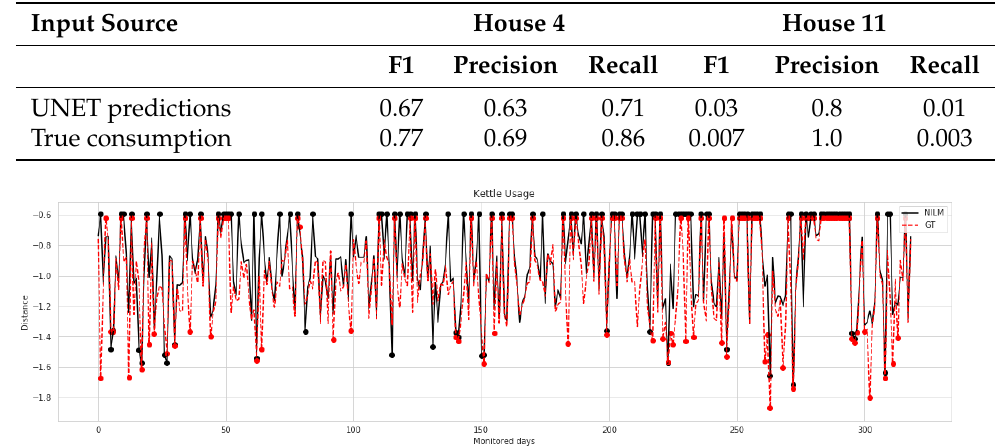
Figure 8. The Jensen–Shannon Divergence (JSD) in the case of house